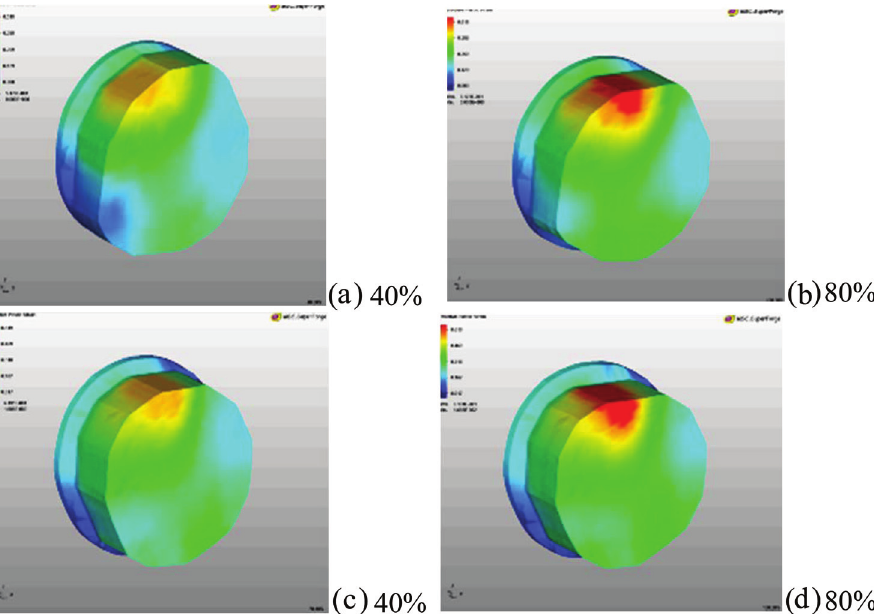
Figure 3: Picture of deformation intensity distribution when forging in the combined baizes with angles of rotation 90° (a and b) and 120° (c and d), t ¼ 960°C.